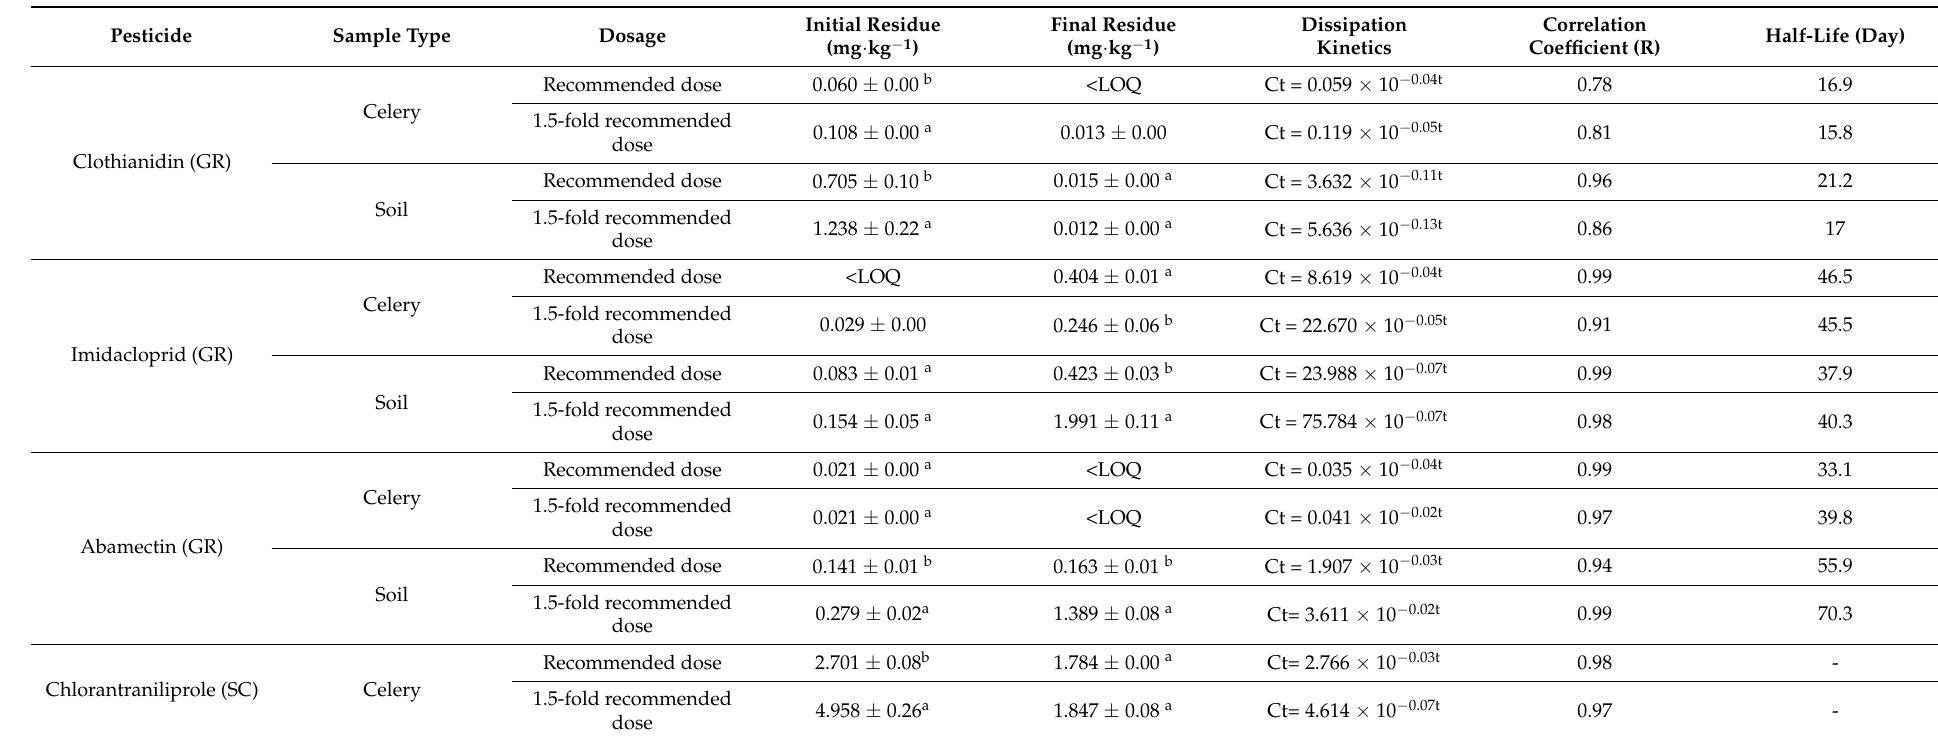
Table 6. Residual kinetics and half-life of four pesticides in celery under recommended dose and 1.5-fold recommended dose